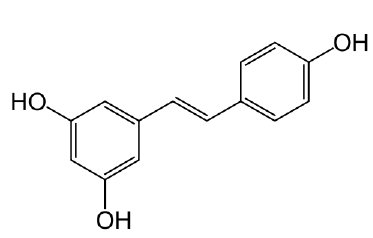
Figure 3. Resveratrol